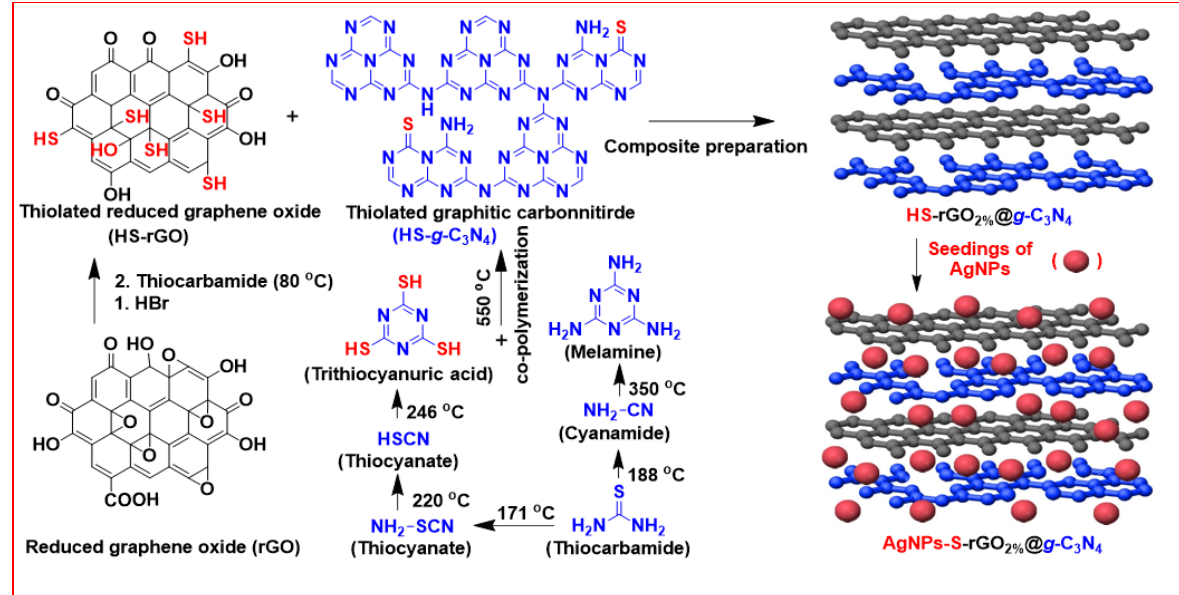
Figure 1. Scheme for the synthesis of AgNPs-S-rGO 2% @ g -C 3 N 4 .